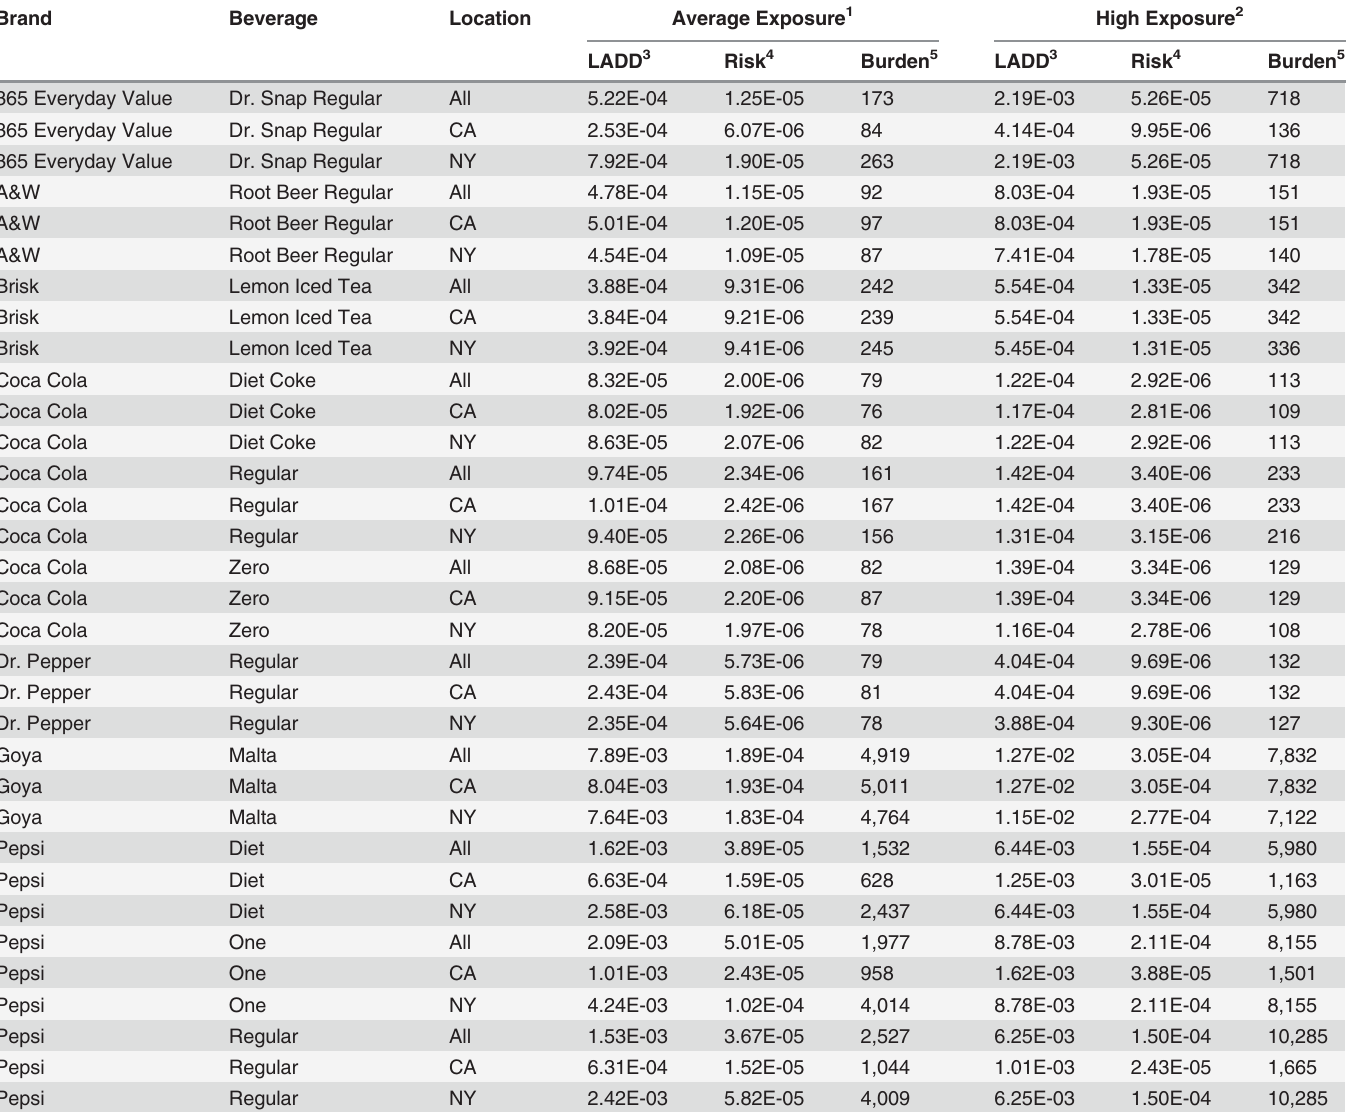
Table 4. Exposure to 4-MEI and Cancer Risk and Burden, by Beverage and